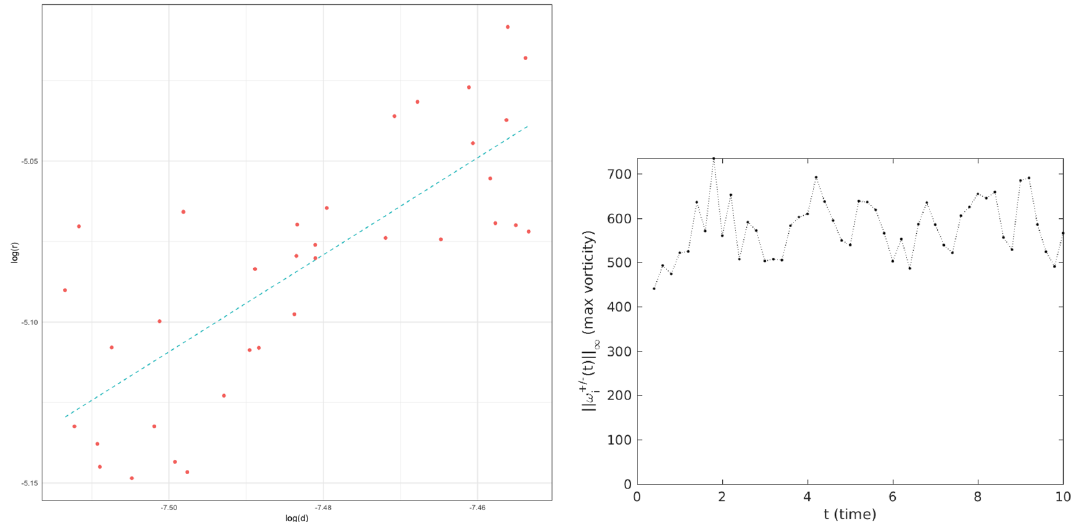
Figure 4. The figure on the left represents the linear regression after the cyclic component of the data was filtered out and the figure on the right the time-evolution of the vorticity magnitude. The summary of the regression is as follows fit = [ 1.5 ± 0.2 ] log d + [ 6.1 ± 0.16 ]